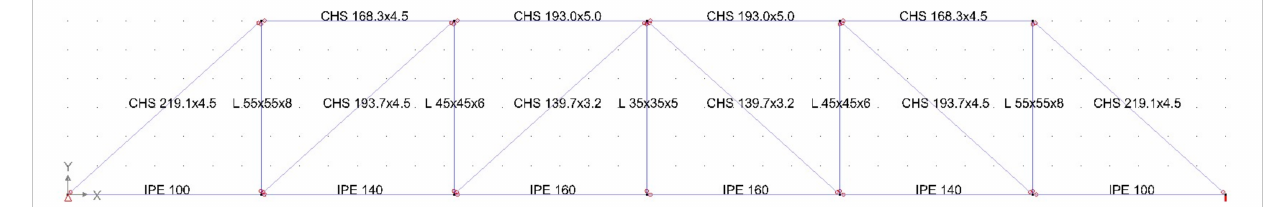
Figure 8. Howe truss, span L = 40 m, height H = 6 m, number of panels n = 6, optimal standard sections are